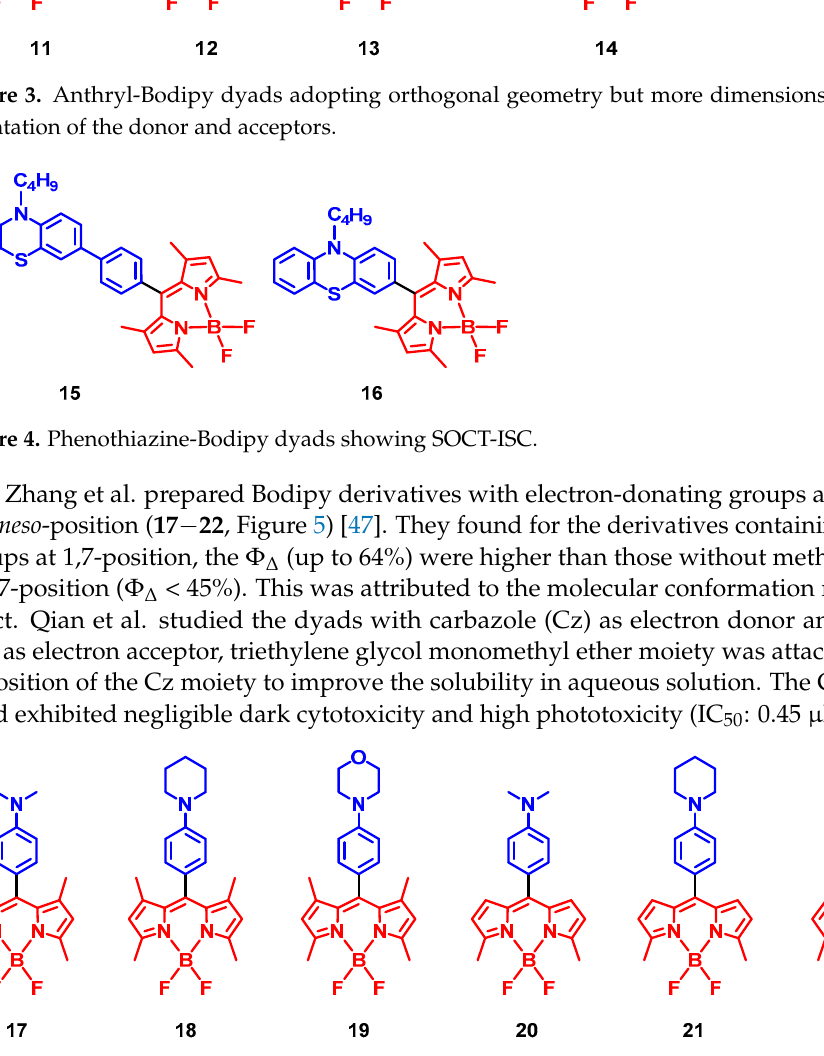
Figure 5. Molecular structures of the Bodipy-derived dyads with electron-donating moieties attached at the meso -position.